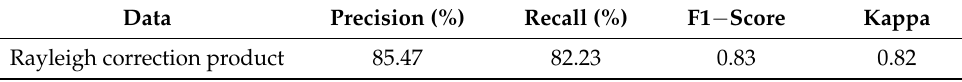
Table 6. Red tide detection accuracy of RDU − Net using the Rayleigh correction